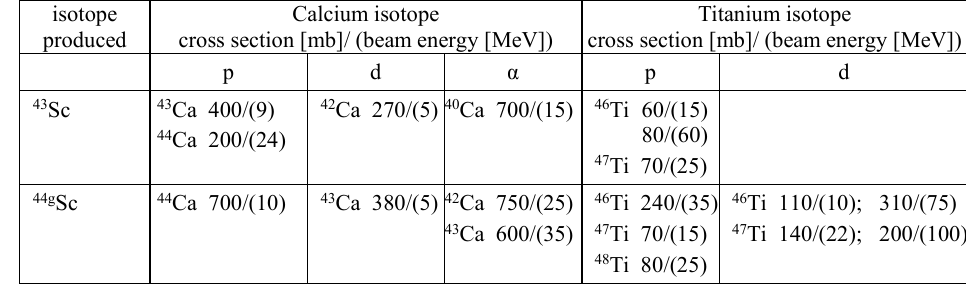
Table 1. Example of cross sections for production of 43 Sc and 44g Sc on reactions of Ca or Ti with p, d or α [ 4].